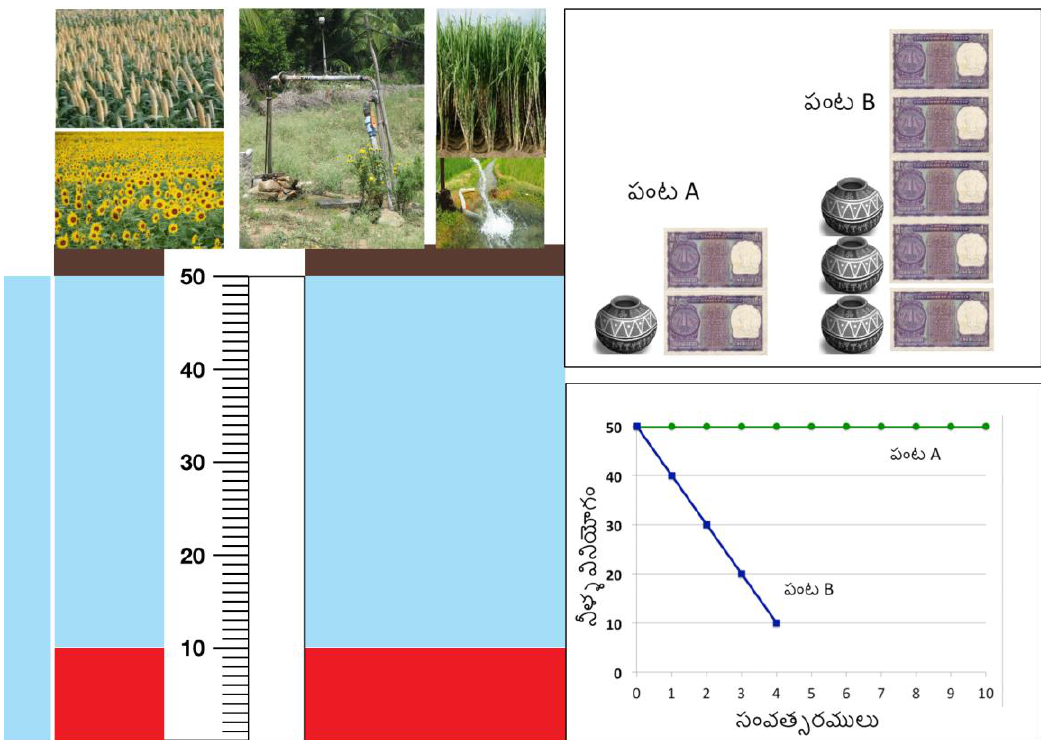
Figure 2. Water Level